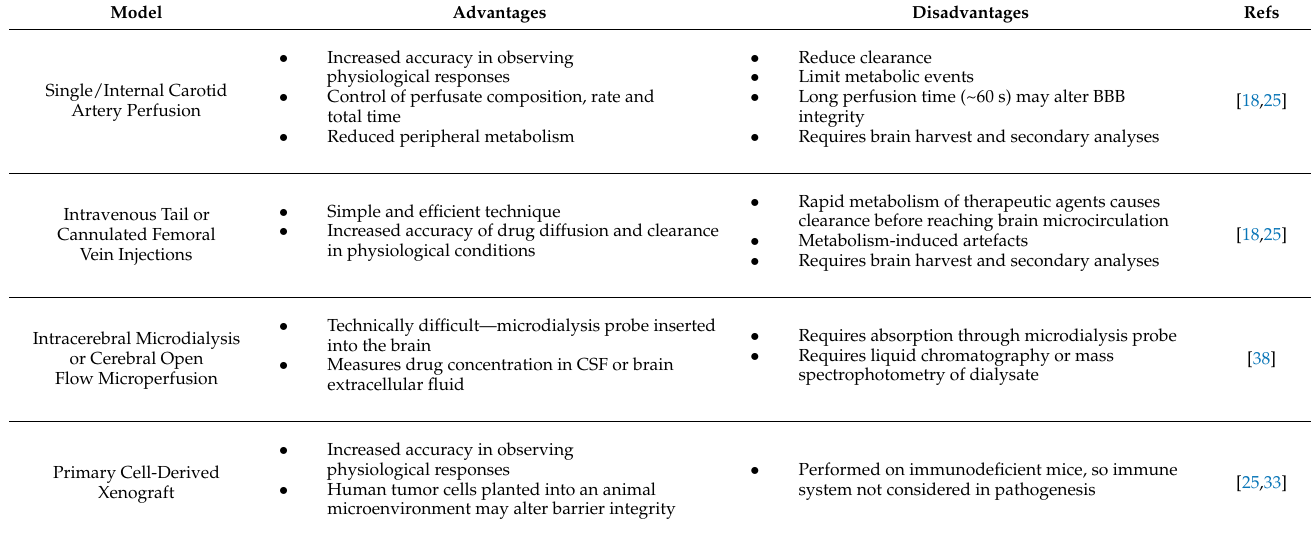
Table 2. In vivo BBB/BBTB models and their advantages and